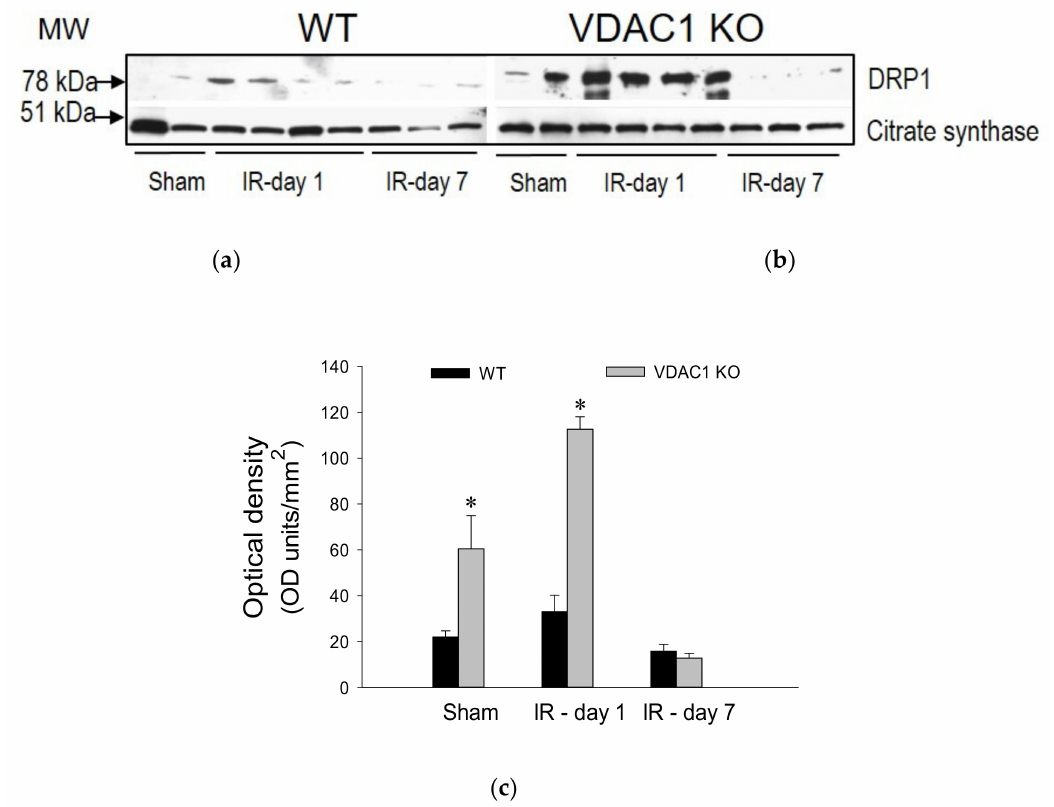
Figure 10. Deletion of VDAC1 induces mitochondrial fission in non-injured and ischemia-injured renal cortex. Protein levels of dynamin-related protein 1 (DRP1) on days 1 and 7 of recovery after bilateral renal ischemia (IR) in WT ( a ) and VDAC1 KO mice ( b ). ( c ) Densitometric analysis of the immunoblots shown in ( a ) and ( b ). The blots represent renal cortical mitochondria obtained from sham-operated animals and four mice sacrificed on day 1 (IR-day 1) and 3 mice sacrificed on day 7 (IR-day 7) post reperfusion in three di ff erent experiments. * Values significantly di ff erent ( p < 0.05) from the mitochondria of respective WT